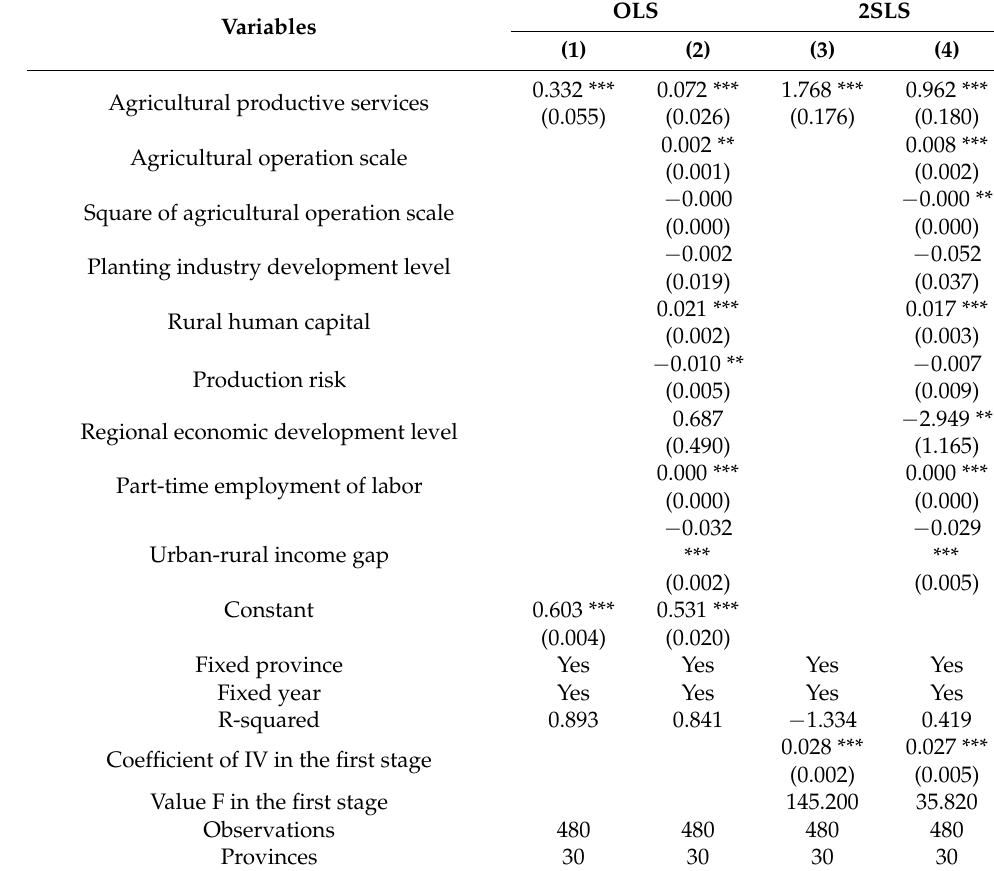
Table 3. Impact of agricultural productive services on agricultural environmental